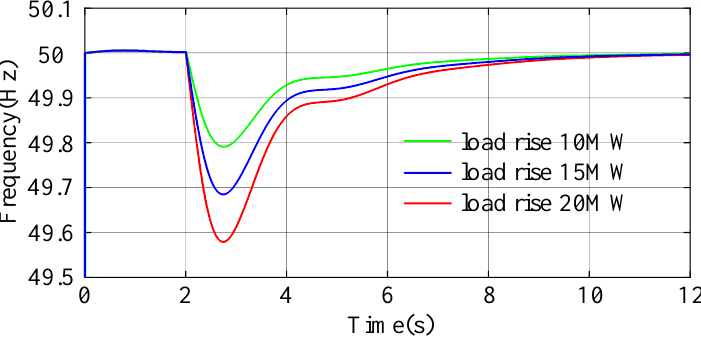
Figure 29. System frequency regulation curve under different surge load power.